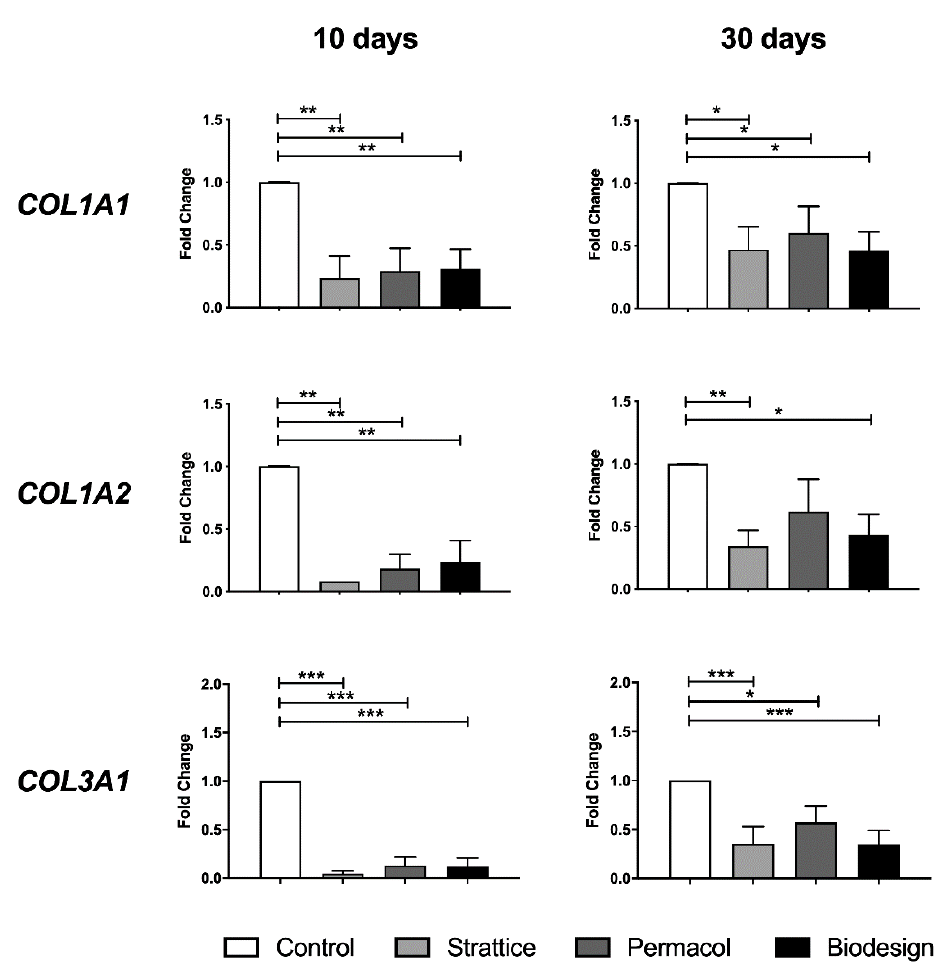
Figure 3. Changes in the levels of collagen transcripts following fibroblast growth on the different types of matrices for 10 or 30 days compared to the control condition — expression from fibroblasts grown on plastics (control), Strattice, Permacol, and Biodesign. Values are the means of four independent experiments ± standard error (SE). The results were analyzed with ANOVA. Asterisks indicate significant differences (* p < 0.05; ** p < 0.01; *** p < 0.001). No significant difference between the examined biological matrices was observed.